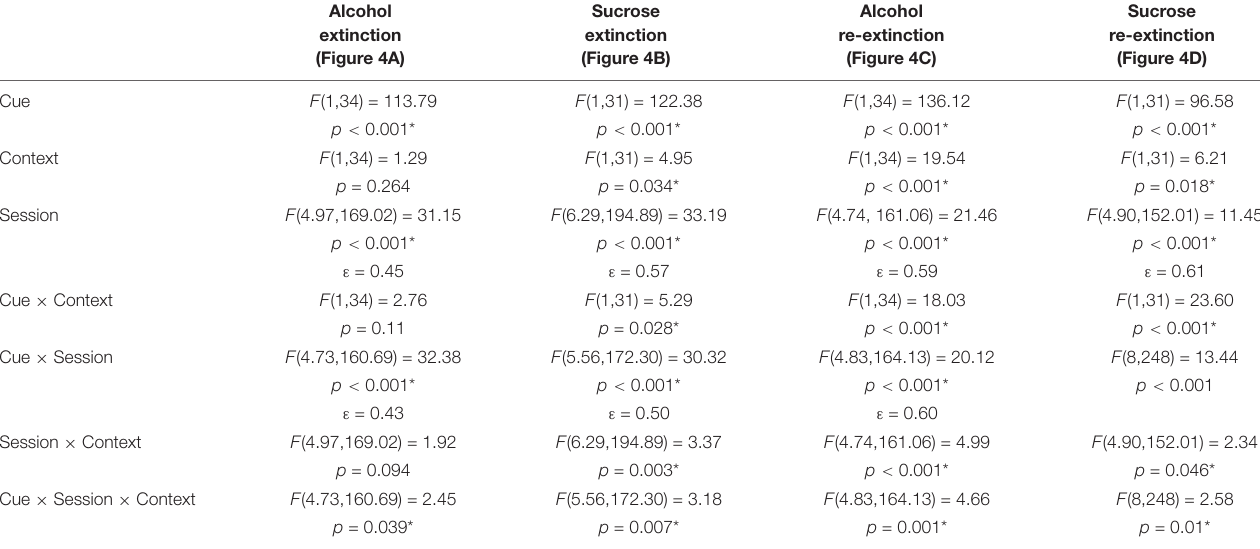
TABLE 3 | Statistical results of analysis of context-based differences in